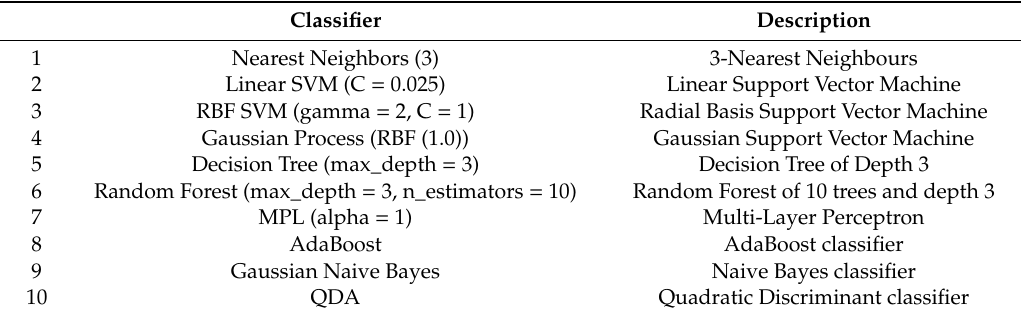
Table 4. Types of classifier.